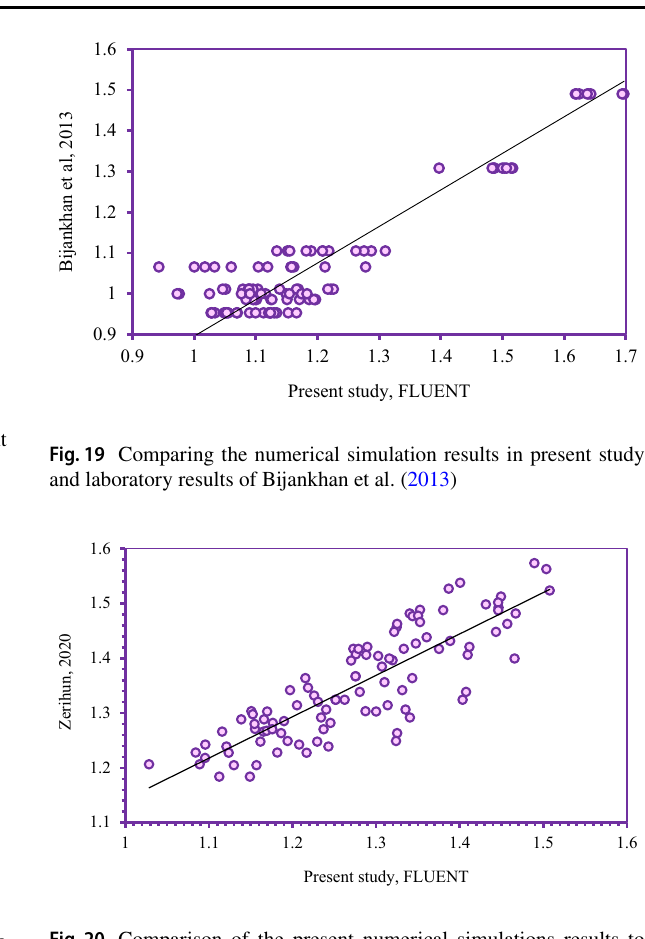
Fig. 18 Comparison of the present numerical simulation results to laboratory results of Sargison and Percy (2009)